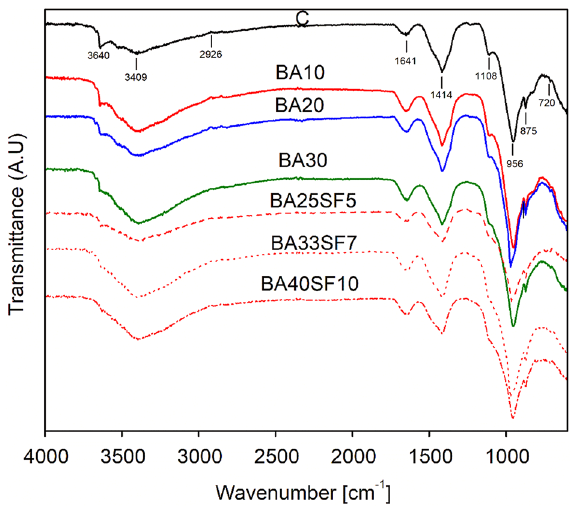
Figure 11. FTIR spectra of 91 days cured paste samples of control and other binary (OPC-BA) and ternary (OPC-BA-SF) concrete mixes.